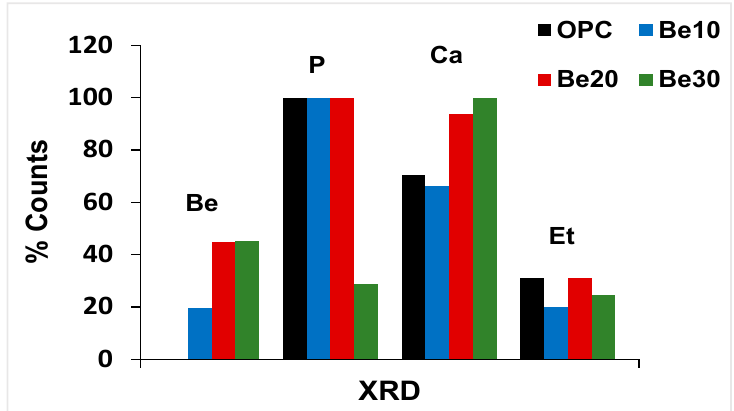
Figure 7. Crystalline phases identified on the XRD patterns for the reference and bentonite-bearing mixes: counts (%).